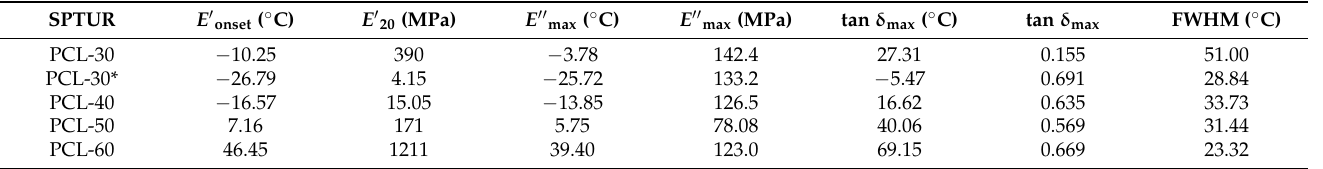
Table 5. DMTA results of the